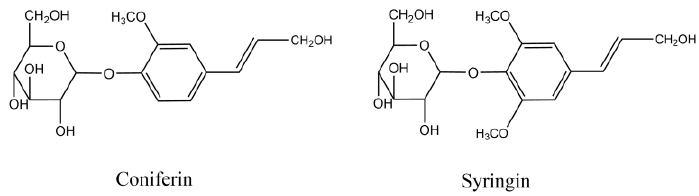
Figure 16. Chemical structure of coniferin and syringin.